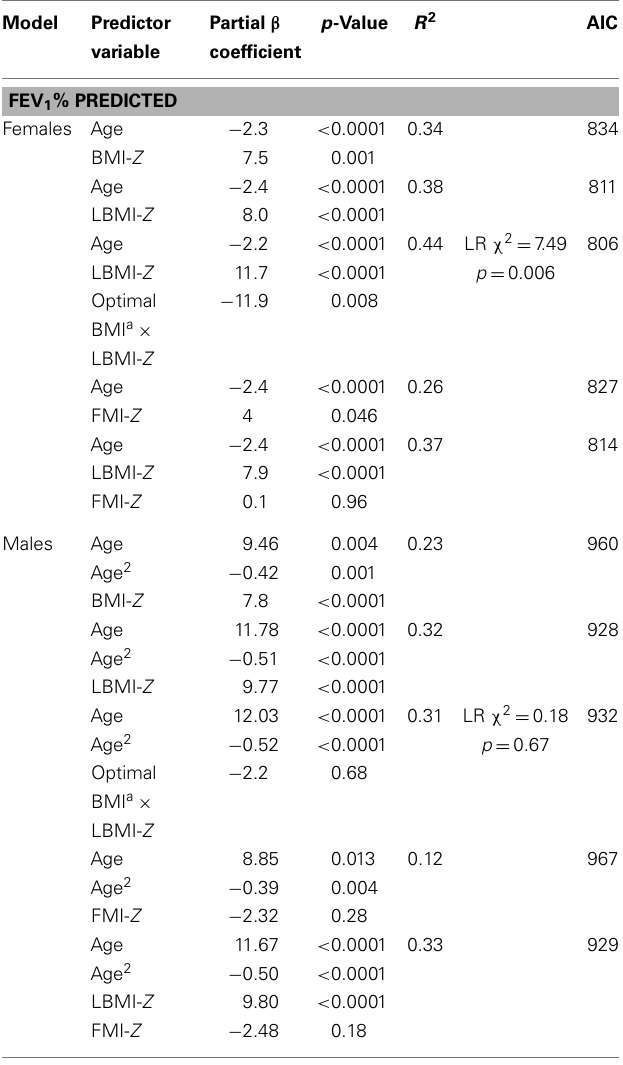
Table 3 | Relationship of body composition and pulmonary function in